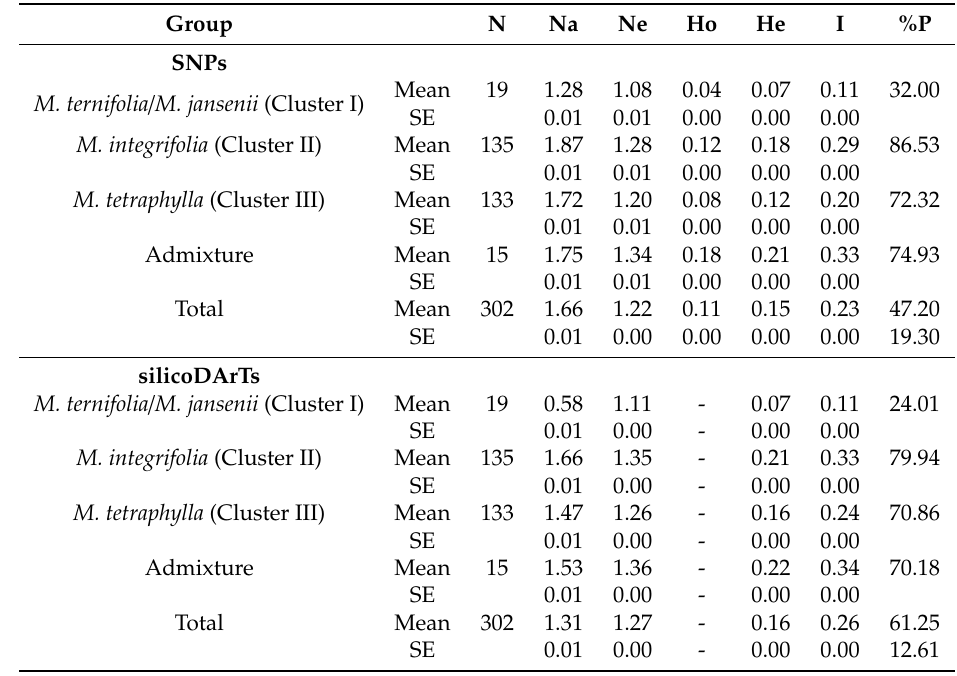
Table 1. Genetic diversity parameters for Macadamia accessions based on SNP and silicoDArT markers. N = number of accessions, Na = number of di ff erent alleles, Ne = number of e ff ective alleles, I = Shannon’s information index, Ho = observed heterozygosity, He = expected heterozygosity, %P = percentage of polymorphic loci, SE = standard error.